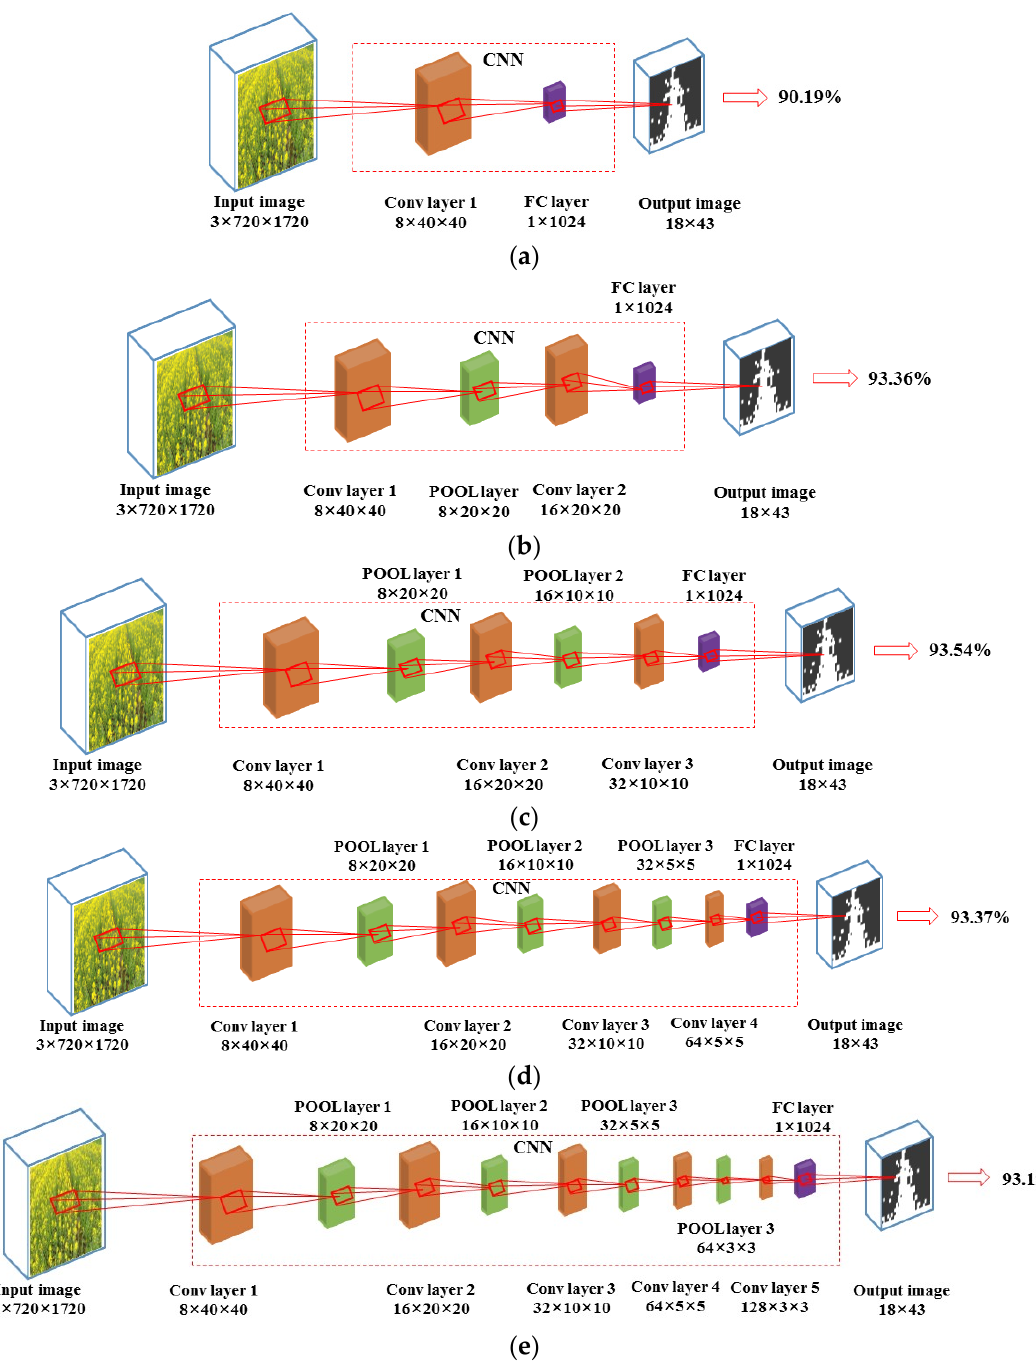
Figure 6. CNN recognition accuracy analysis of different Conv layers with one FC layer; ( a ) Accuracy of C1 + FC1 CNN structure; ( b ) Accuracy of C2 + FC1 CNN structure; ( c ) Accuracy of C3 + FC1 CNN structure; ( d ) Accuracy of C4 + FC1 CNN structure; ( e ) Accuracy of C5 + FC1 CNN